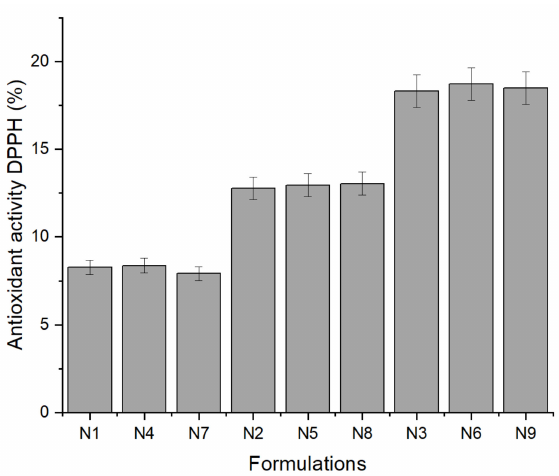
Figure 2. The antioxidant activity of in situ gel formulations measured with the DPPH method. Data represent mean standard deviation (SD), n =